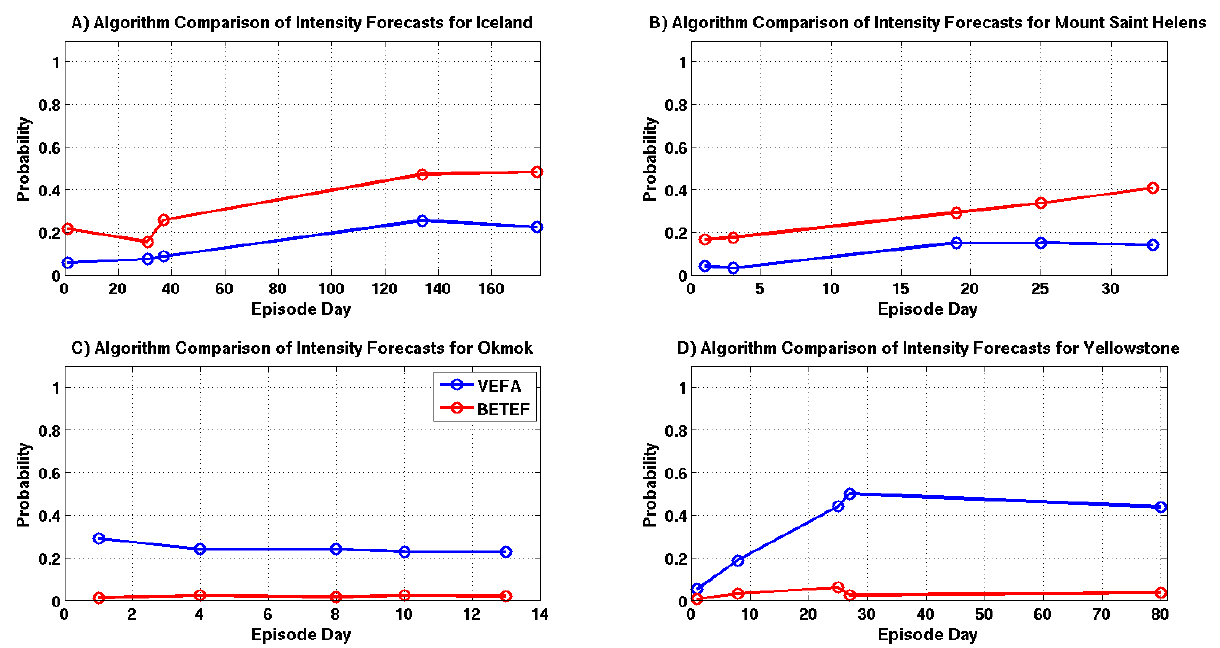
Figure 19. Intensity probability comparisons for selected episode days, where each time sample is highlighted with a circle and the VEFA and BETEF results are shown in blue and